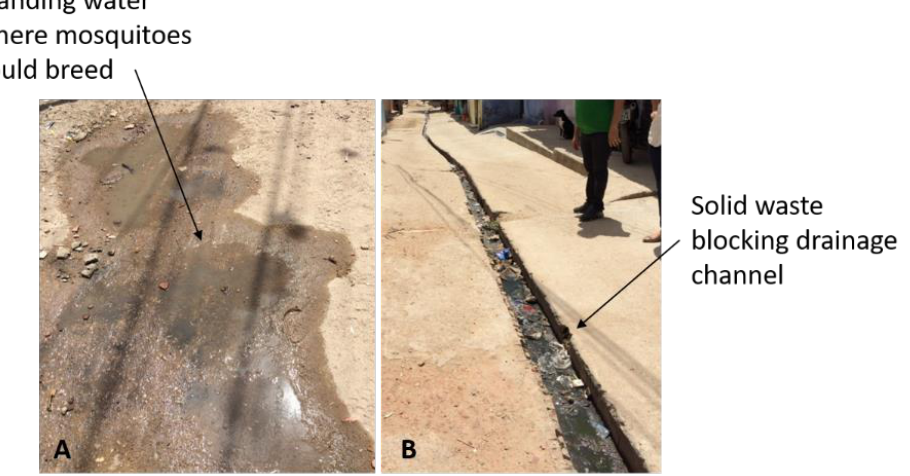
Figure 3. Conventional drainage, Ouro Preto, blocked with solid waste.